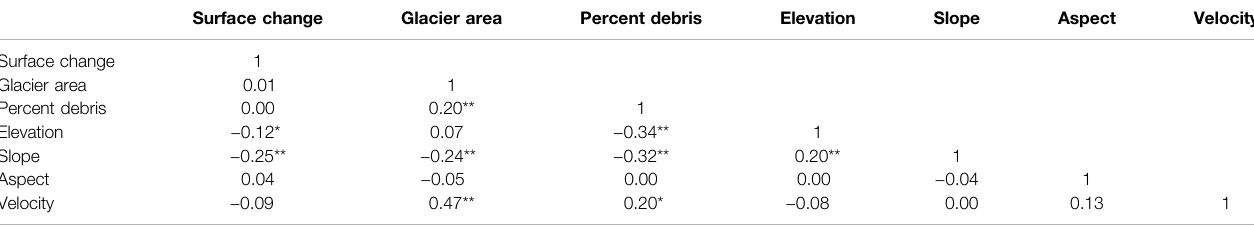
TABLE6| CorrelationmatrixformorphologycontrolsonglaciersurfacechangefortheManasluregionforthe135validglacierswithpositivecorrelationsshowningreenand negative correlations in red. Statistically signi fi cant correlations are marked with “ ** ” and “ * ” for 95 and 90% con fi dence level, respectively. Variables are expressed as average slope, aspect and elevation, median velocity and percent debris. Elevation changes are expressed as ma − 1 for the period 2013 –